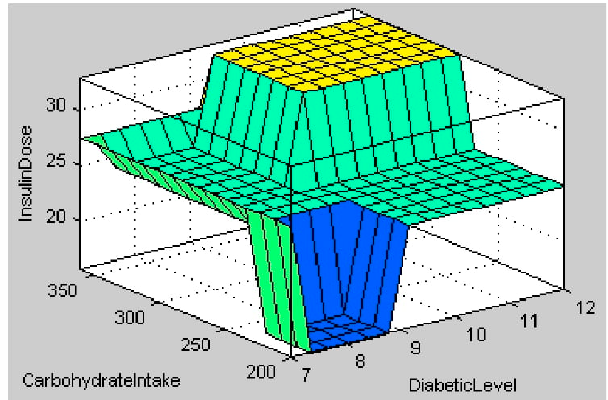
Figure 17. Output Insulin calculation based on the rules.